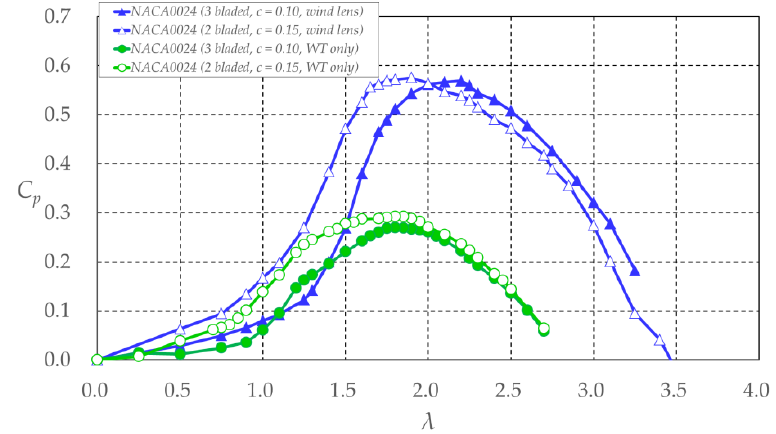
Figure 16. Comparison of power coefficient C p of wind turbines with same solidity and different blade numbers with and without a wind lens vs. tip speed ratio λ (wind lens: L = 1.14 D m, h = 0.5 D m, φ = 15°). Refer to Figure 2 for L , D , h , and φ.